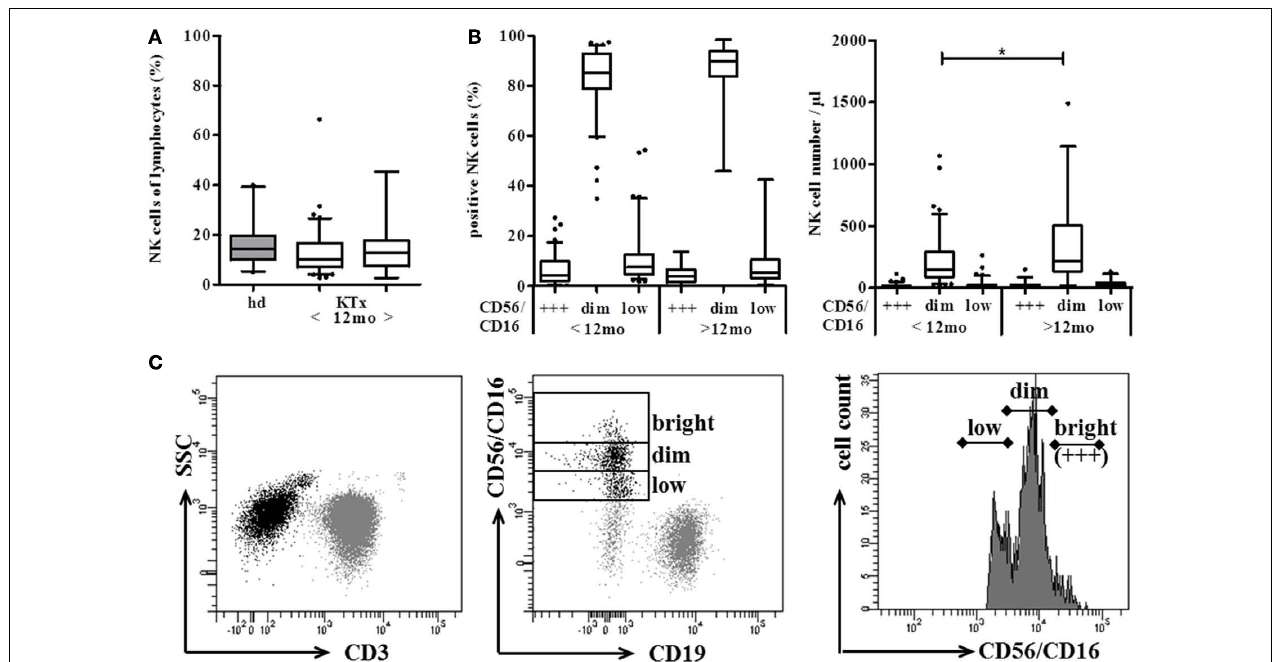
histogram analysis of the CD16/CD56 PE-staining. NK cells were either calculated as % NK cells of lymphocytes (left) or plotted as absolute NK cell numbers per µ l blood (right). (C) Gating strategy of theTrucount™ staining procedure: CD45 + CD3 − lymphocytes (left) were classified into CD56 + CD16 + NK cells and CD19 + B cells (middle). According to their PE-staining, CD56 + CD16 + NK cells were then further subgrouped into CD56/16 bright ( +++ ), CD56/16 dim , and CD56/16 low NK cells (right).The box plots show median values and the whiskers represent the 5–95 percentiles. Asterisks indicate the p -values, * is defined as p ≤ 0.05, ** as p ≤ 0.01, and *** as p ≤